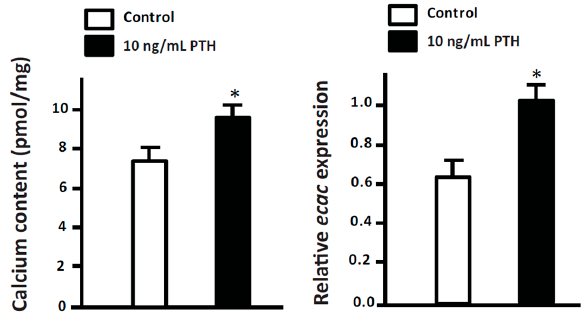
Figure 3. Effect of human parathyroid hormone (PTH) amide on whole-body ECaC mRNA expression and calcium content in 3-dpf zebrafish embryos. One to two cell-stage zebrafish embryos were